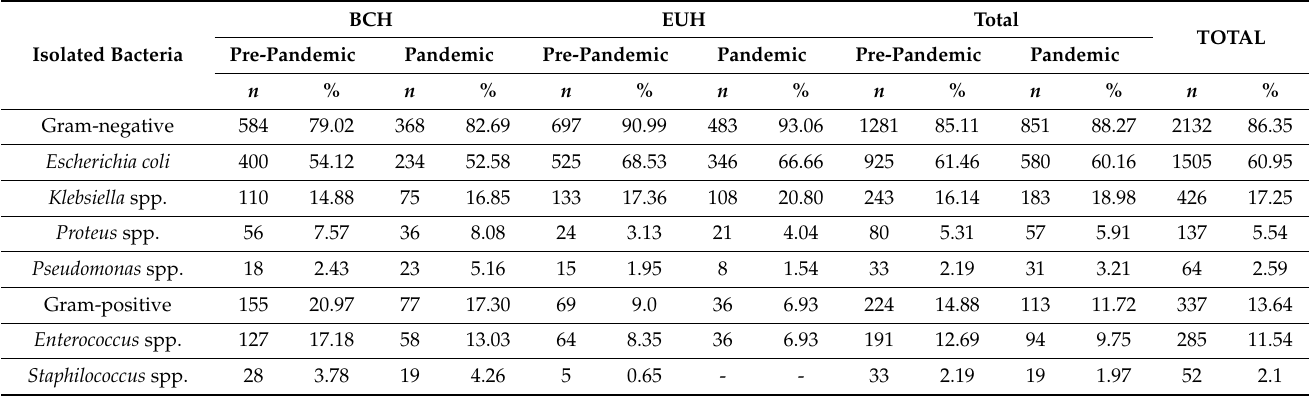
Table 1. Table 1. Bacterial strains isolated in the study group.